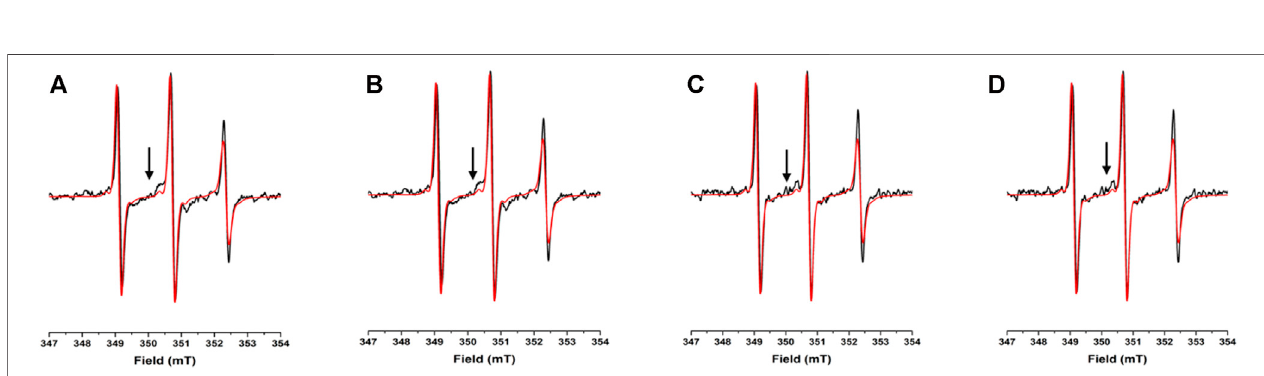
FIGURE 3 | EPR spectra under different conditions for N72C-MTSL : X-band CW-EPR spectra at room temperature of NUPR1 N72C-MTSL in buffer (red) and in presence of crowders (black): Ficoll-70 at 50 mg/ml (A) and 150 mg/ml (B) , Dextran-40 at 50 mg/ml (C) and 150 mg/ml (D) .